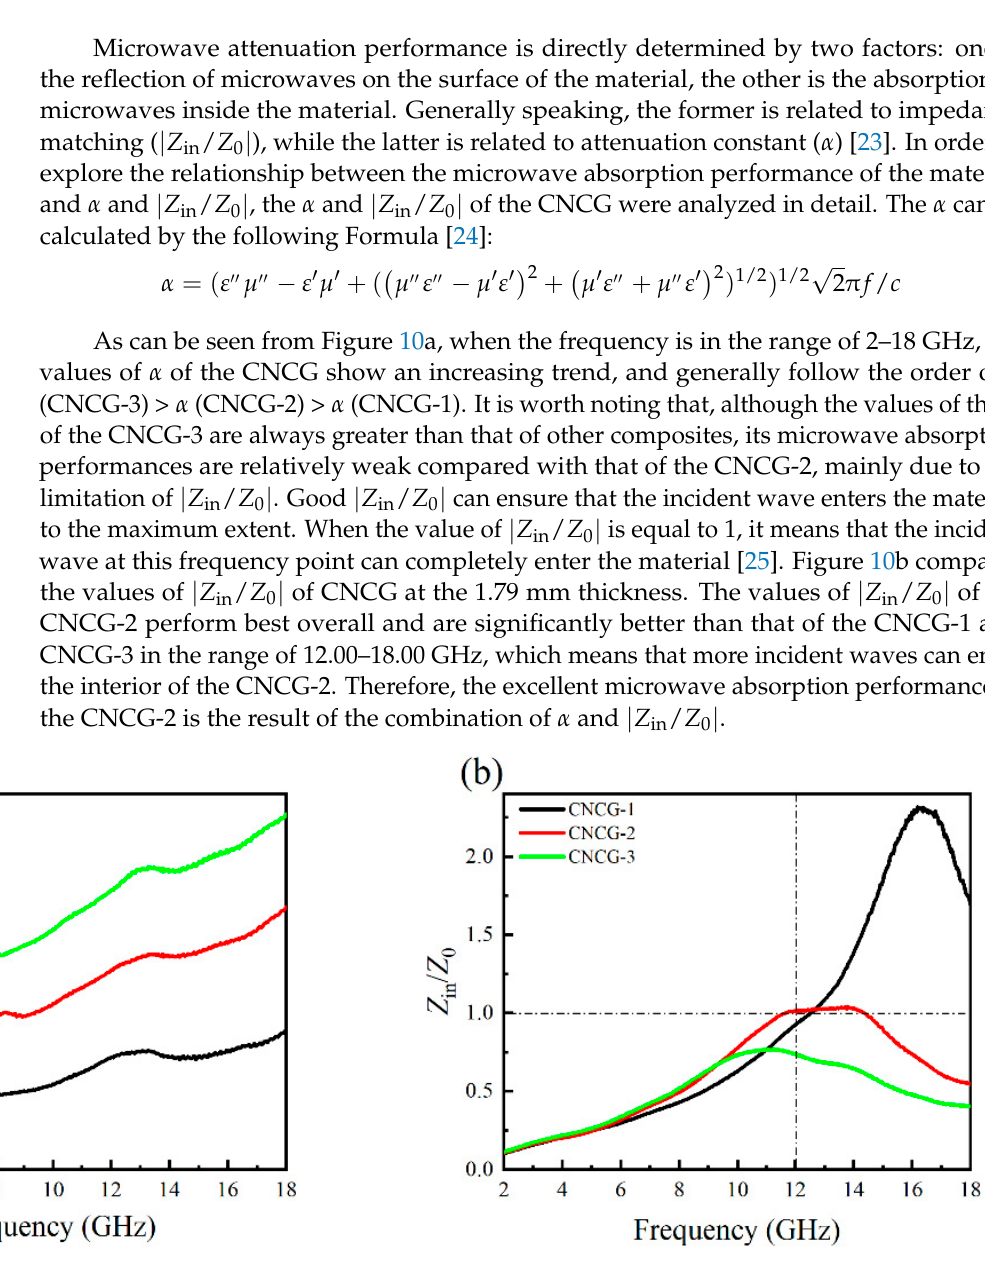
| /𝑍 (cid:2919)(cid:2924) (cid:2868)